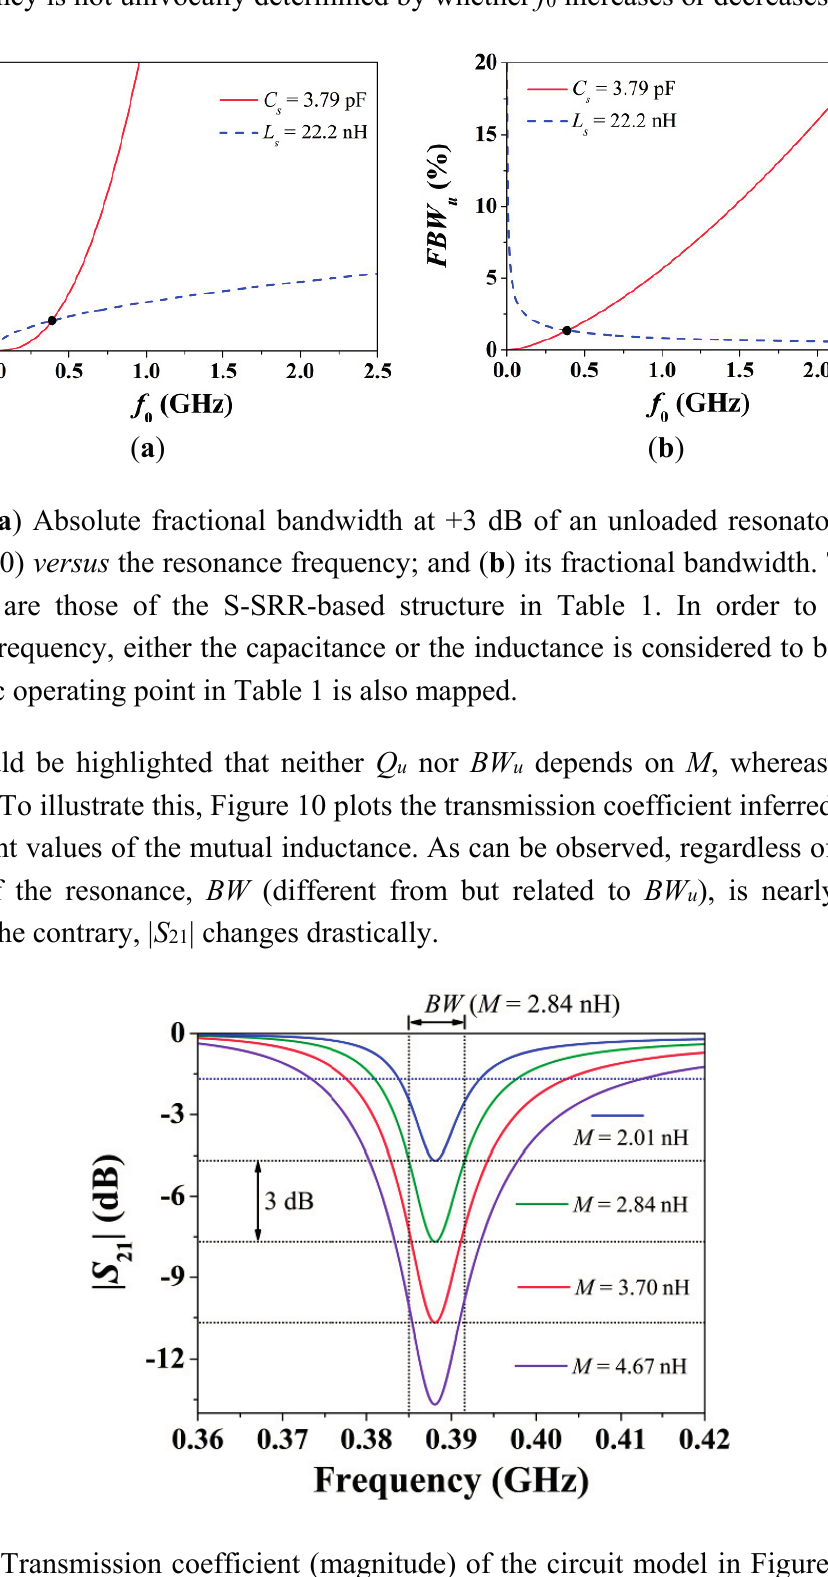
Figure 10. Transmission coefficient (magnitude) of the circuit model in Figure 5a for the circuit parameters of the S-SRR-loaded CPW in Table 1, where M is varied such that the notch depth is changed by steps of ±3